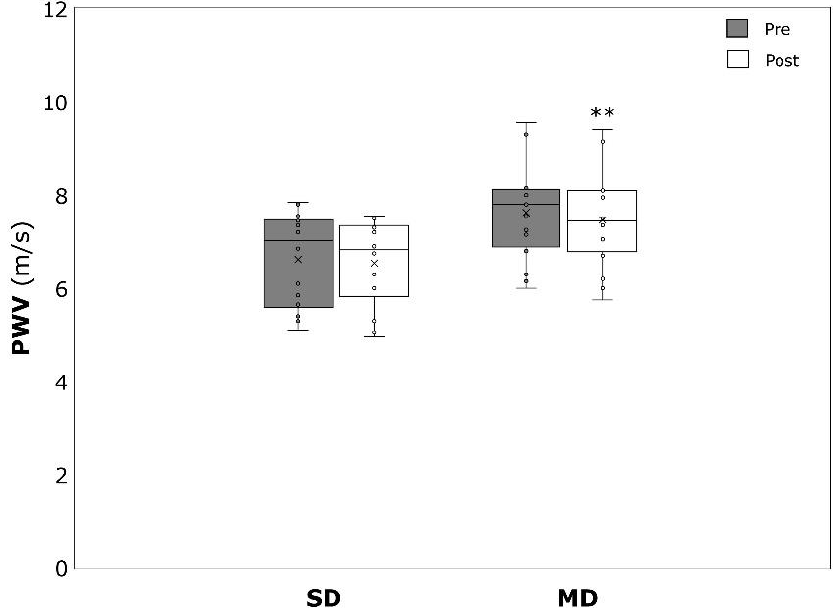
Figure 6. Pulse wave velocity (PWV) pressure before (pre) and after (post) the intervention period for severely depressed (SD) and mildly depressed (MD). ** p < 0.01 within-group difference.